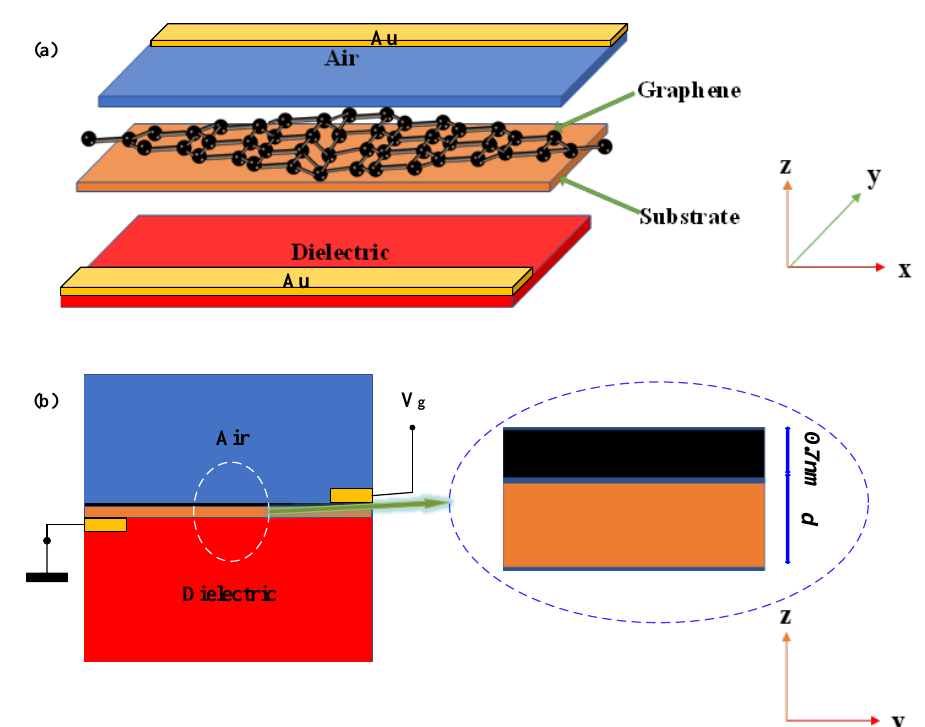
Figure 1. The stereograph and sectional view of this modulator: ( a ) 3D layout waveguide structure, ( b ) cross-section structure .